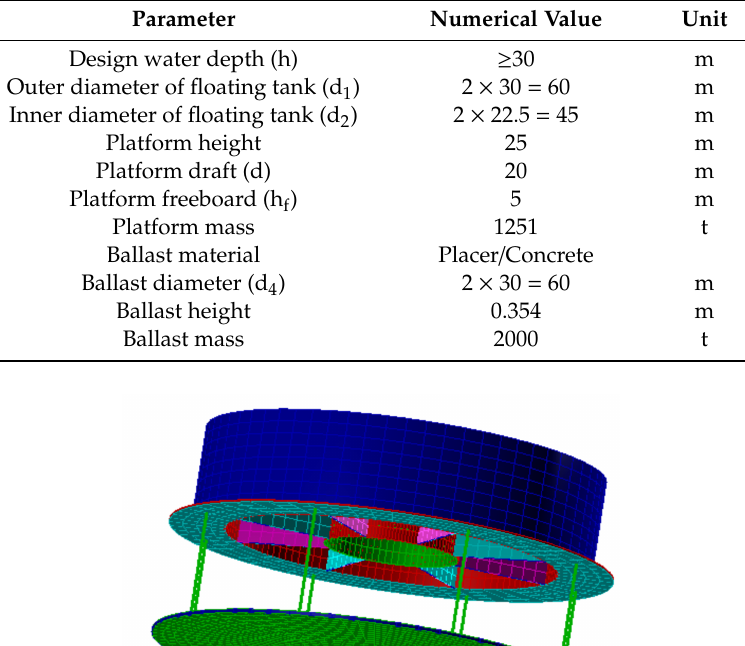
Table 2. Parameters of the barge platform with moon pool.